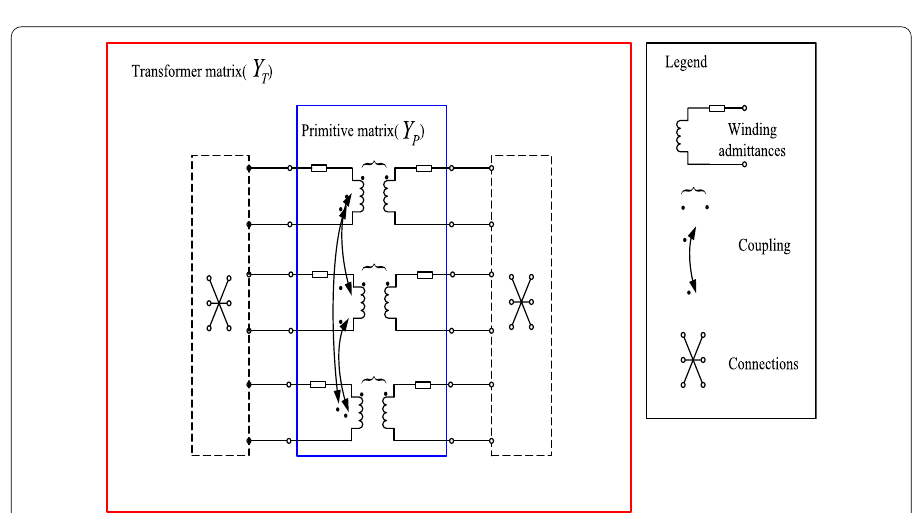
Fig. 1 Conceptual scheme of the construction; In red box, the model of the transformer is showed. Besides three-phase coins connections in Primary side and secondary side, there are self-inductance and mutual inductance in transformer windings (green box and small black box